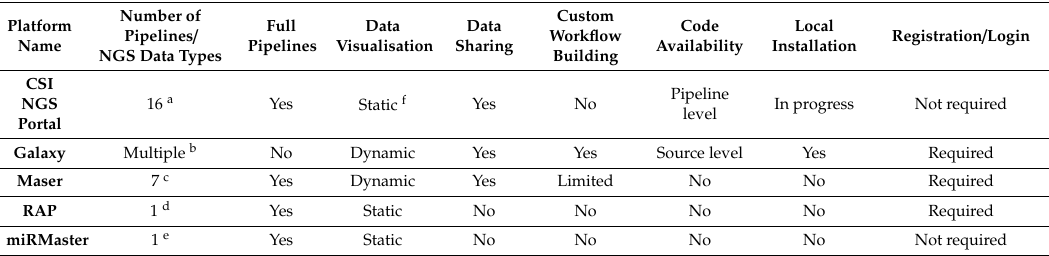
Table 3. Comparison of CSI NGS Portal to other NGS data analysis